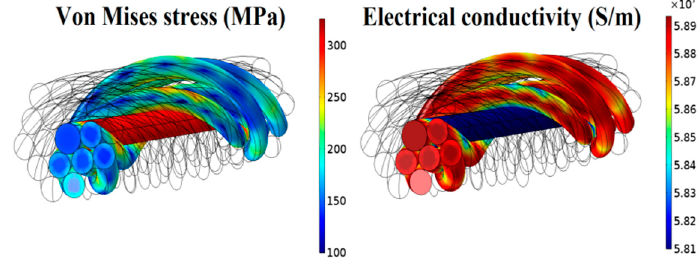
Figure 7. Distribution of the von Mises stress in the conductor in MPa in the plastic range ( left ) and its correspondence in electrical conductivity ( right ).